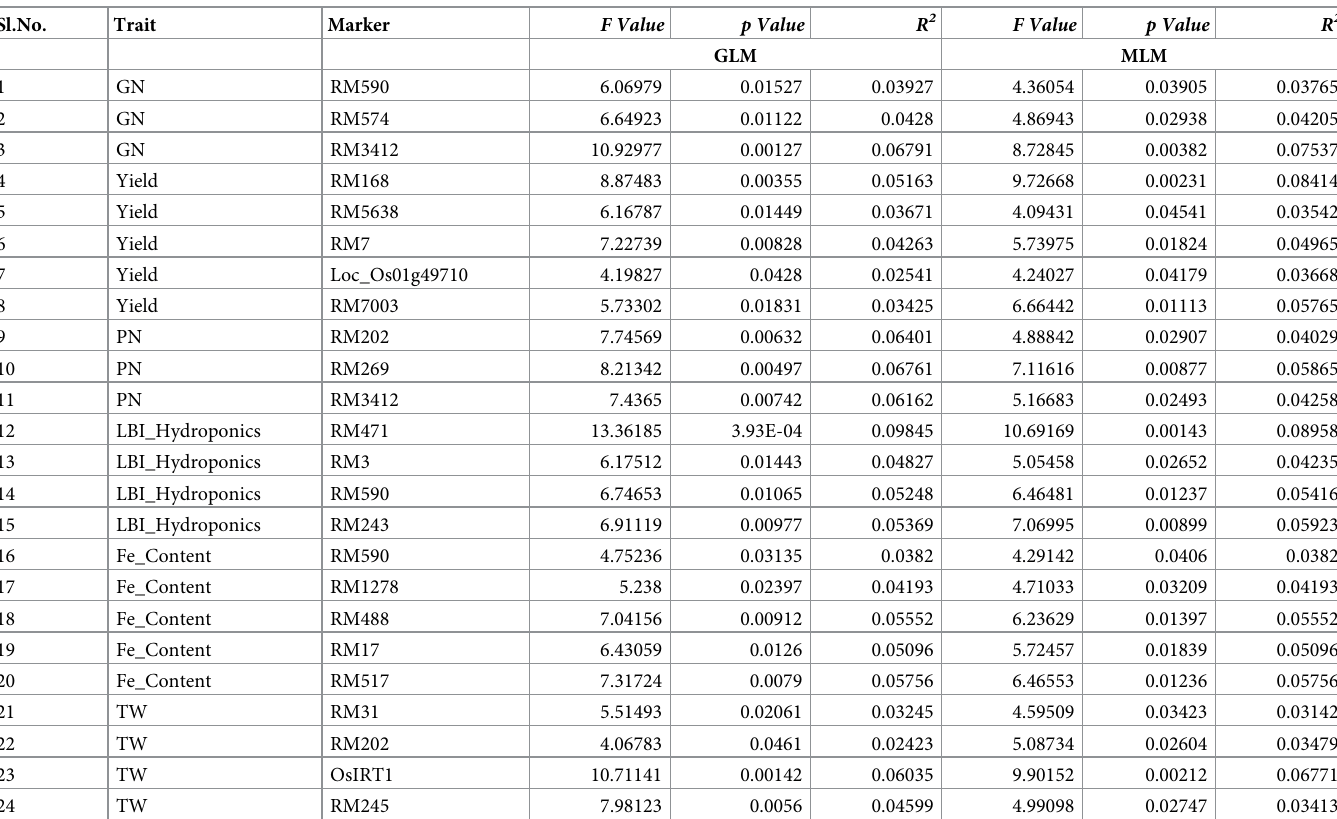
Table 3. Marker-trait association of for the traits leaf bronzing index, grain Fe-content, grain yield and related traits through GLM and MLM approach in rice. Sl.No.